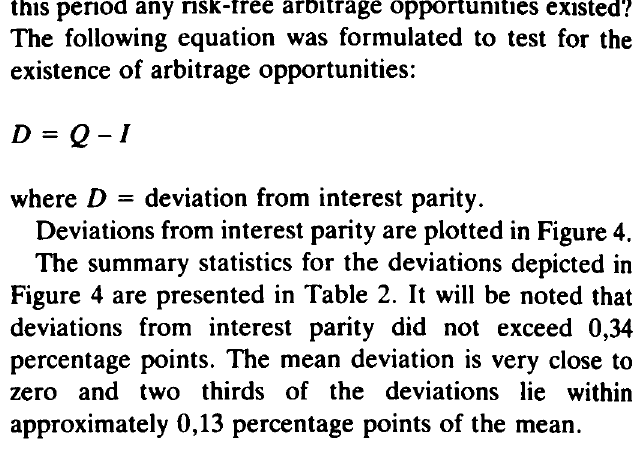
Figwe 4 Deviations from interest parity (Aug 1983 - Aug 1985)